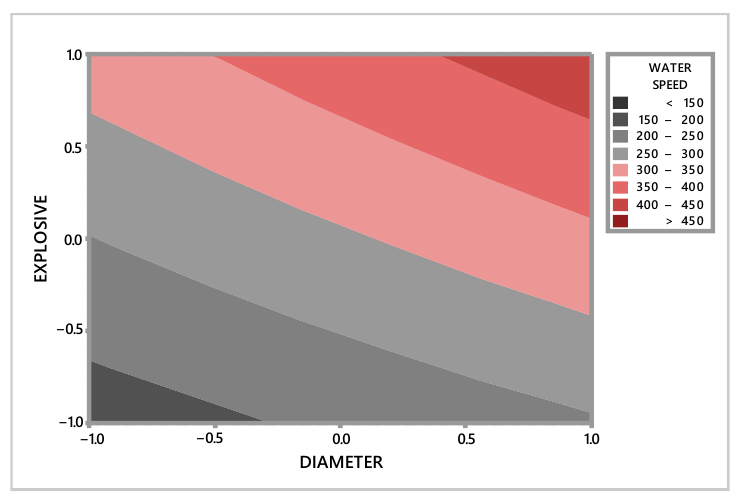
Figure 14. ontour plot of the effect of “ xplosive pecific ass” and “Diameter” factors over the Figure 14. Contour plot of the effect of “Explosive Specific Mass” and “Diameter” factors over the response variable. response